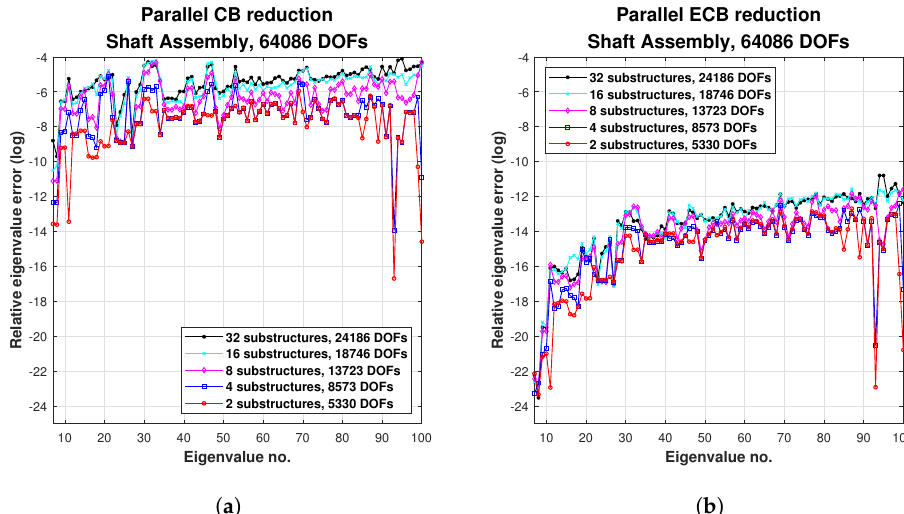
Figure 8. Comparison of reduced model accuracy, shaft assembly. The results are obtained by ( a ) the CB method and ( b ) the ECB method,